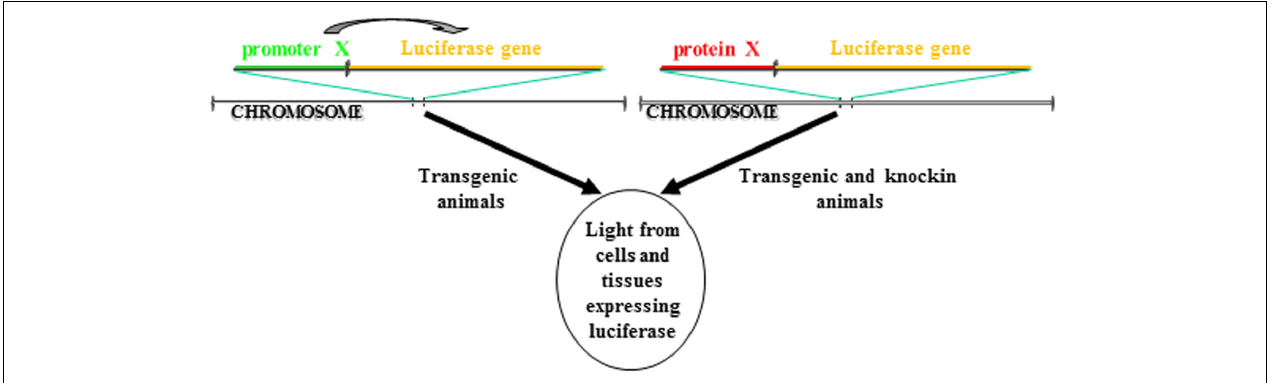
FIGURE 1 | Different strategies to make a luciferase-based transgenic animal. One strategy take advantage of the transgenesis of cassettes in which the luciferase gene transcription is regulated by a promoter. The luciferase will be expressed only in cells in which the promoter is active. In another strategy, the cassette for transgenesis can include a fusion protein between the luciferase and the gene of interest. The cassette can be either knockin into the locus of the gene coding for the protein so that the cassette is under the transcription control of the endogenous promoter or the protein of interest can be directly inserted in frame into the locus. In both cases, the luciferase will be expressed only in cells in which the protein is expressed.